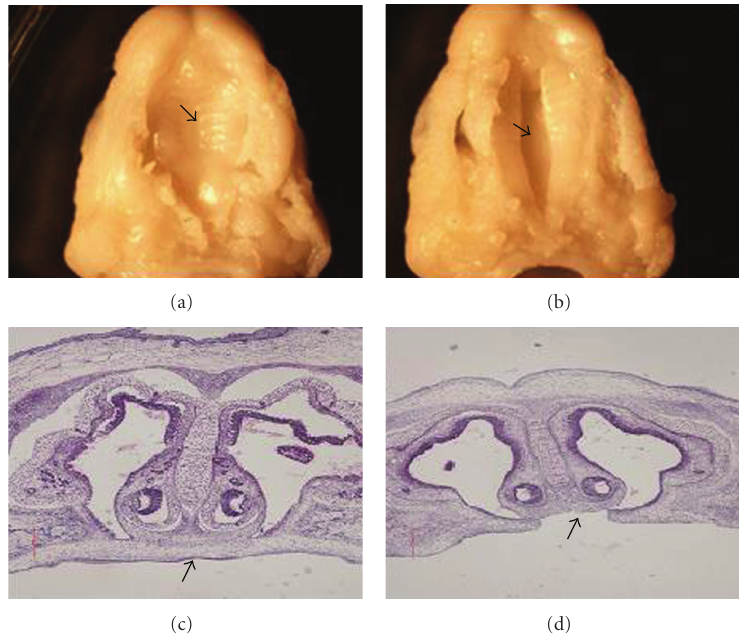
Figure 1: Photos of fusion or lack of fusion by embryonic palatal shelves. The fusion situation of embryonic palatal shelves was observed and photographed. (a) Fused embryonic palatal shelf. (b) Nonfused embryonic palatal shelf. (c) Fused embryonic palatal shelf in histological section. (d) Nonfused embryonic palatal shelf in histological